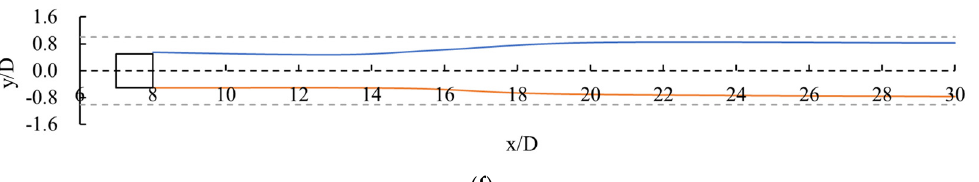
Figure 6. Trajectory of the vortex centres of the flow around a square cylinder under different boundary constraint degrees when R e = 400. ( a ) G / D = 5.5; ( b ) G / D = 3.5; ( c ) G / D = 2.5; ( d ) G / D = 1.5; ( e ) G / D = 1.0; and ( f ) G / D = 0.5.